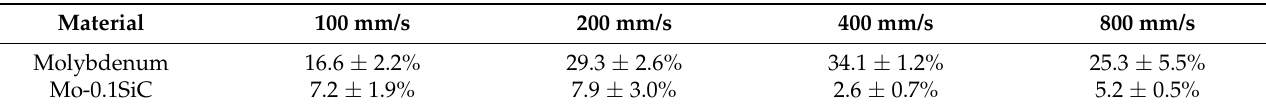
Table 3. Optically determined density values for all prepared